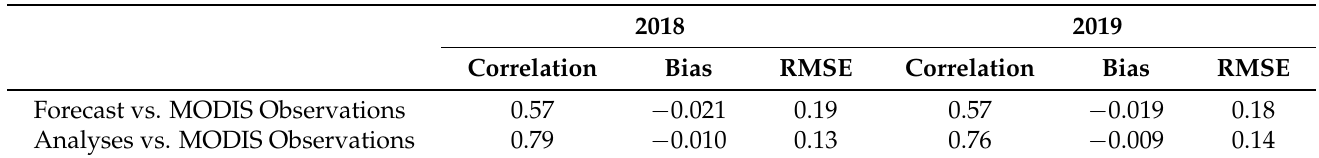
Table 1. Scores in terms of correlation, bias and RMSE between the MODIS AOD observations and the forecasts on one hand, and between the MODIS AOD observations and the analyses on the other hand, for the two years 2018 and